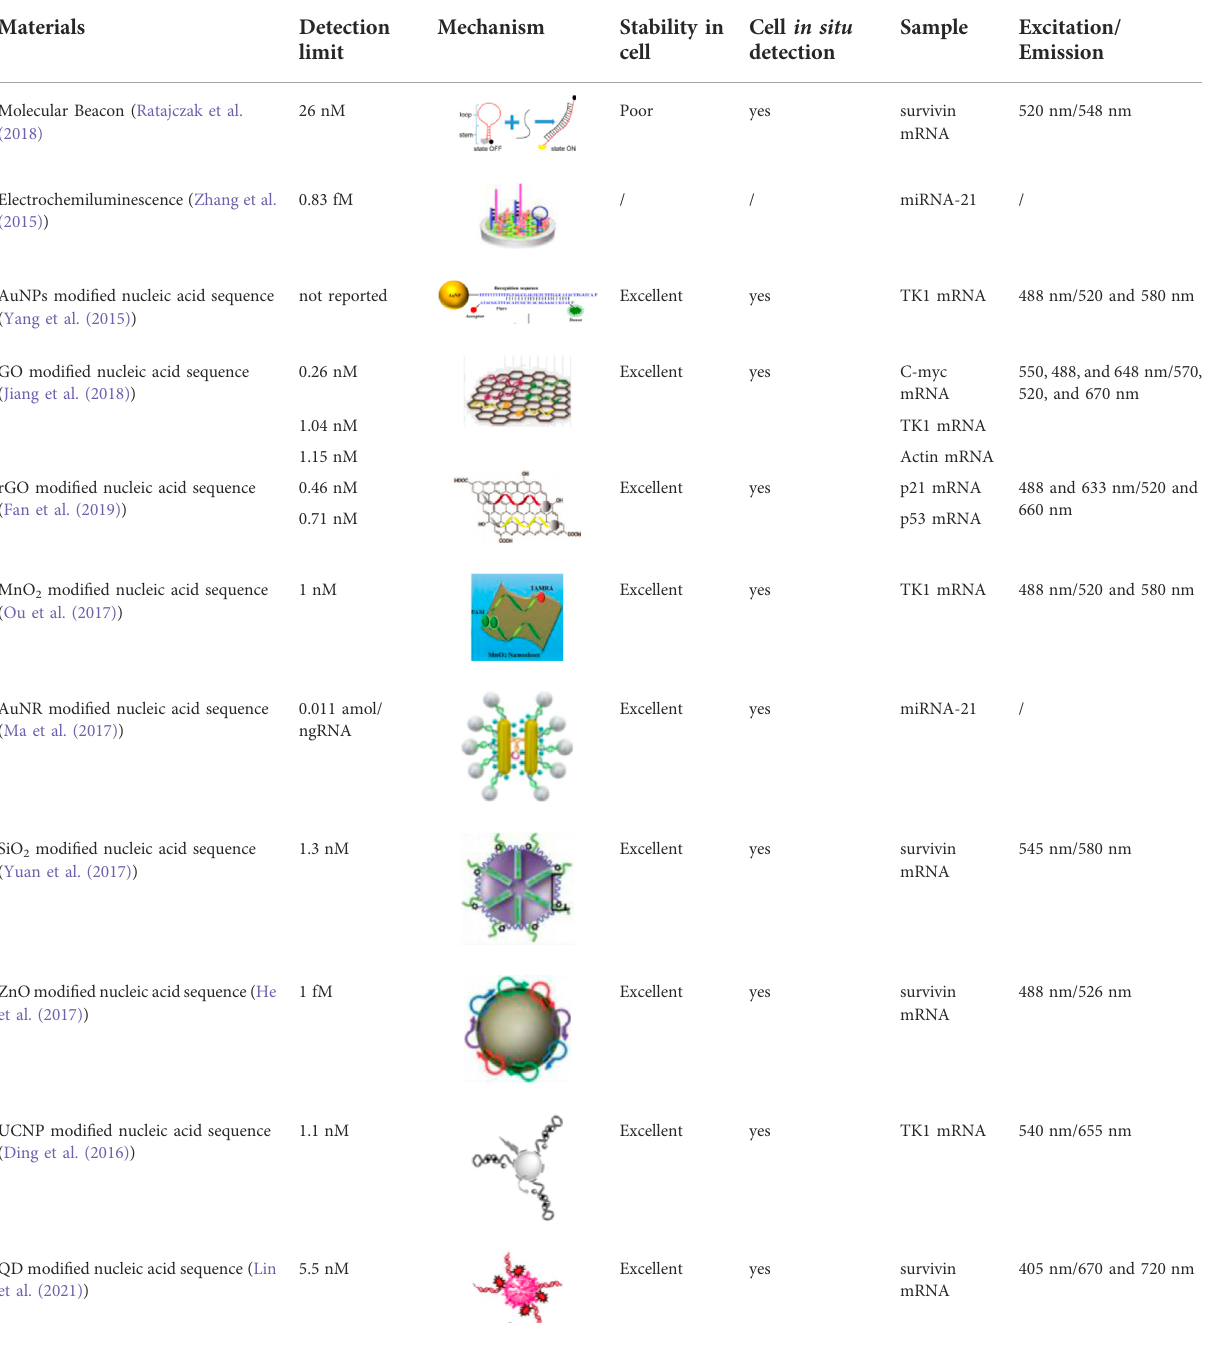
TABLE 2 Different types of DNA-based fl uorescent